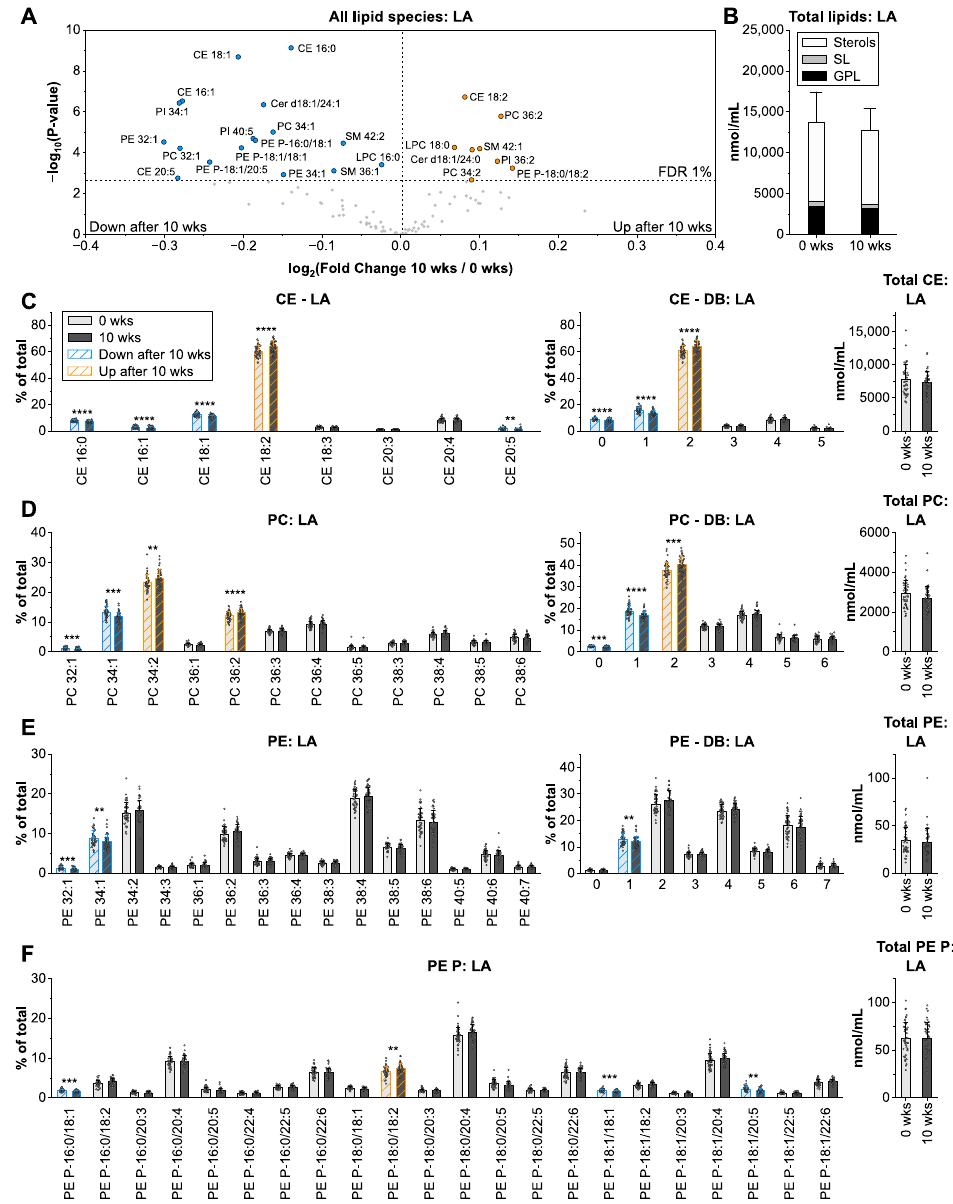
Figure 2. Impact of sunflower oil intervention on the human plasma lipidome. ( A ) Volcano plots showing a significantly different lipid species after 10 weeks (wks) of intervention. ( B ) Total con- centration and distribution of all analyzed lipids. ( C – F ) Lipid species profiles, double bond (DB) composition in FA moieties, and total lipid levels for cholesteryl ester (CE), phosphatidylcholine (PC), phosphatidylethanolamine (PE), and PE-based plasmalogens (PE P). Shown are means ± SD of the lipid species with an average contribution > 1% from n = 45. ** p < 0.01, *** p < 0.001, **** p < 0.0001.